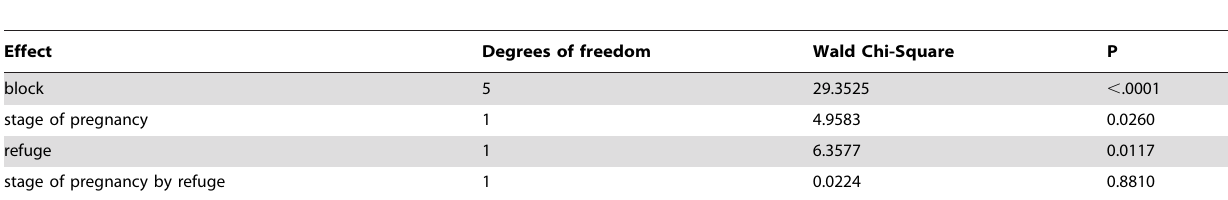
Table 1. Type 3 tests of effects of predictor variables from logistic regression analysis of probability of survival of female western mosquitofish in the presence of a